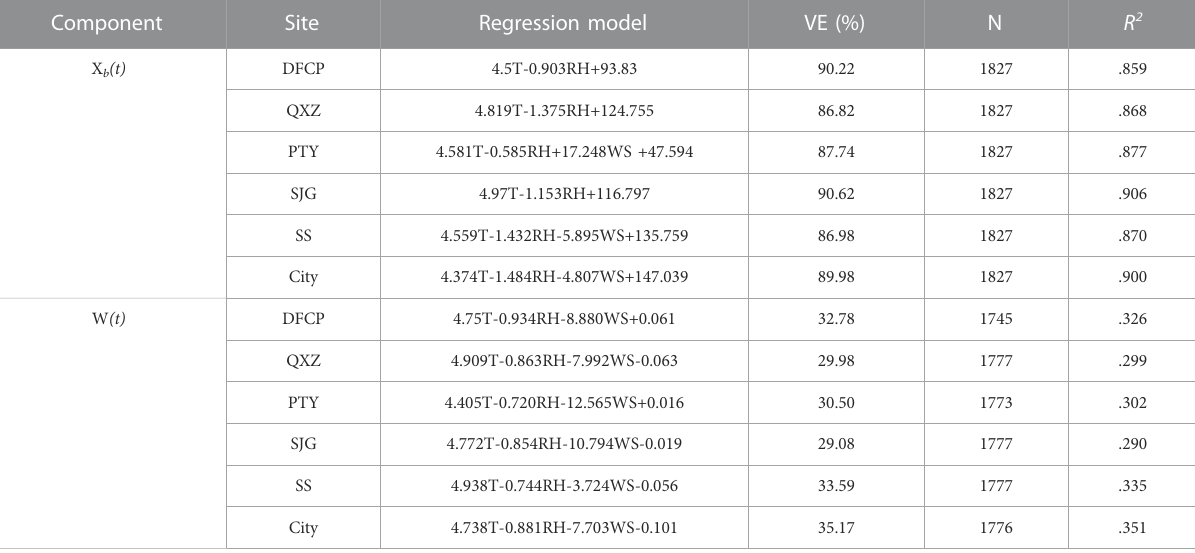
TABLE 2 Stepwise regression model for the baseline and short-term components of MDA8 ozone.